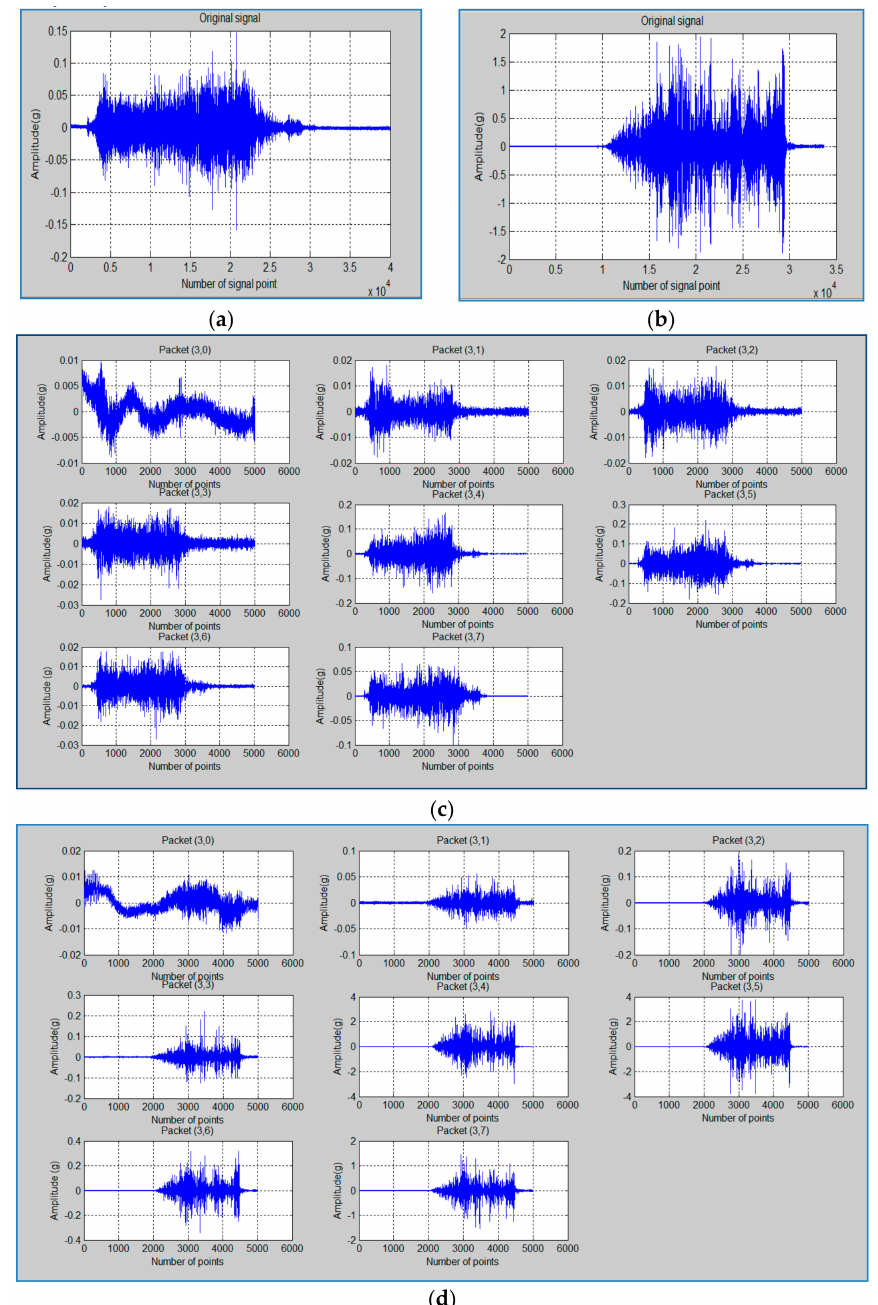
Figure 3. Time signal for ( a ) 1st hole and ( b ) 79th hole of vibration. The wavelet packet signal for ( c ) 1st hole and ( d ) 79th hole of vibration. Data taken in Z direction, and the signal is of cutting condition